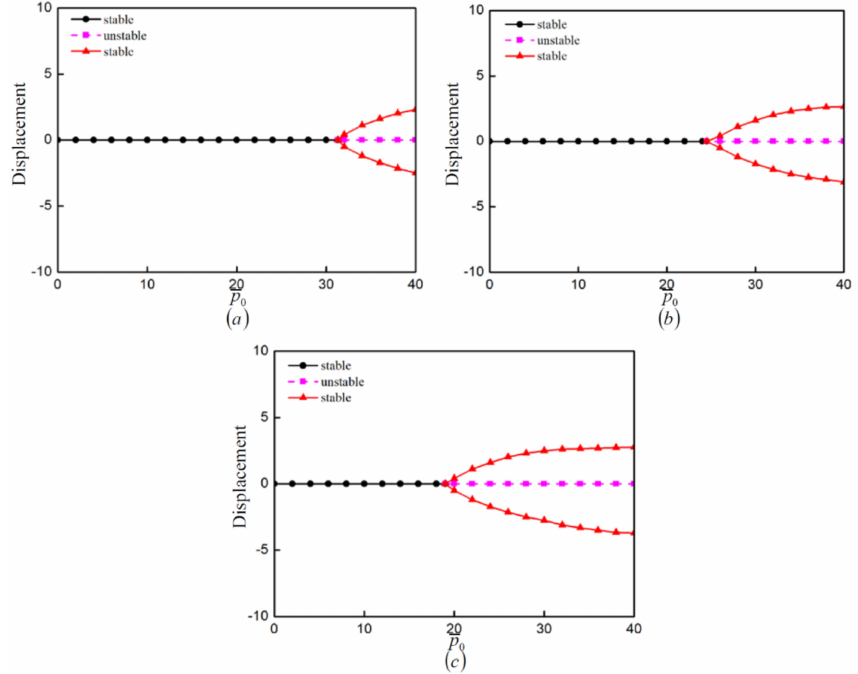
Figure 5. The transverse deflection of the CFRP laminated cylindrical shell versus the static in-plane load with different temperature fields: ( a ) T o = 400 K, ( b ) T o = 500 K, ( c ) T o = 600 K.